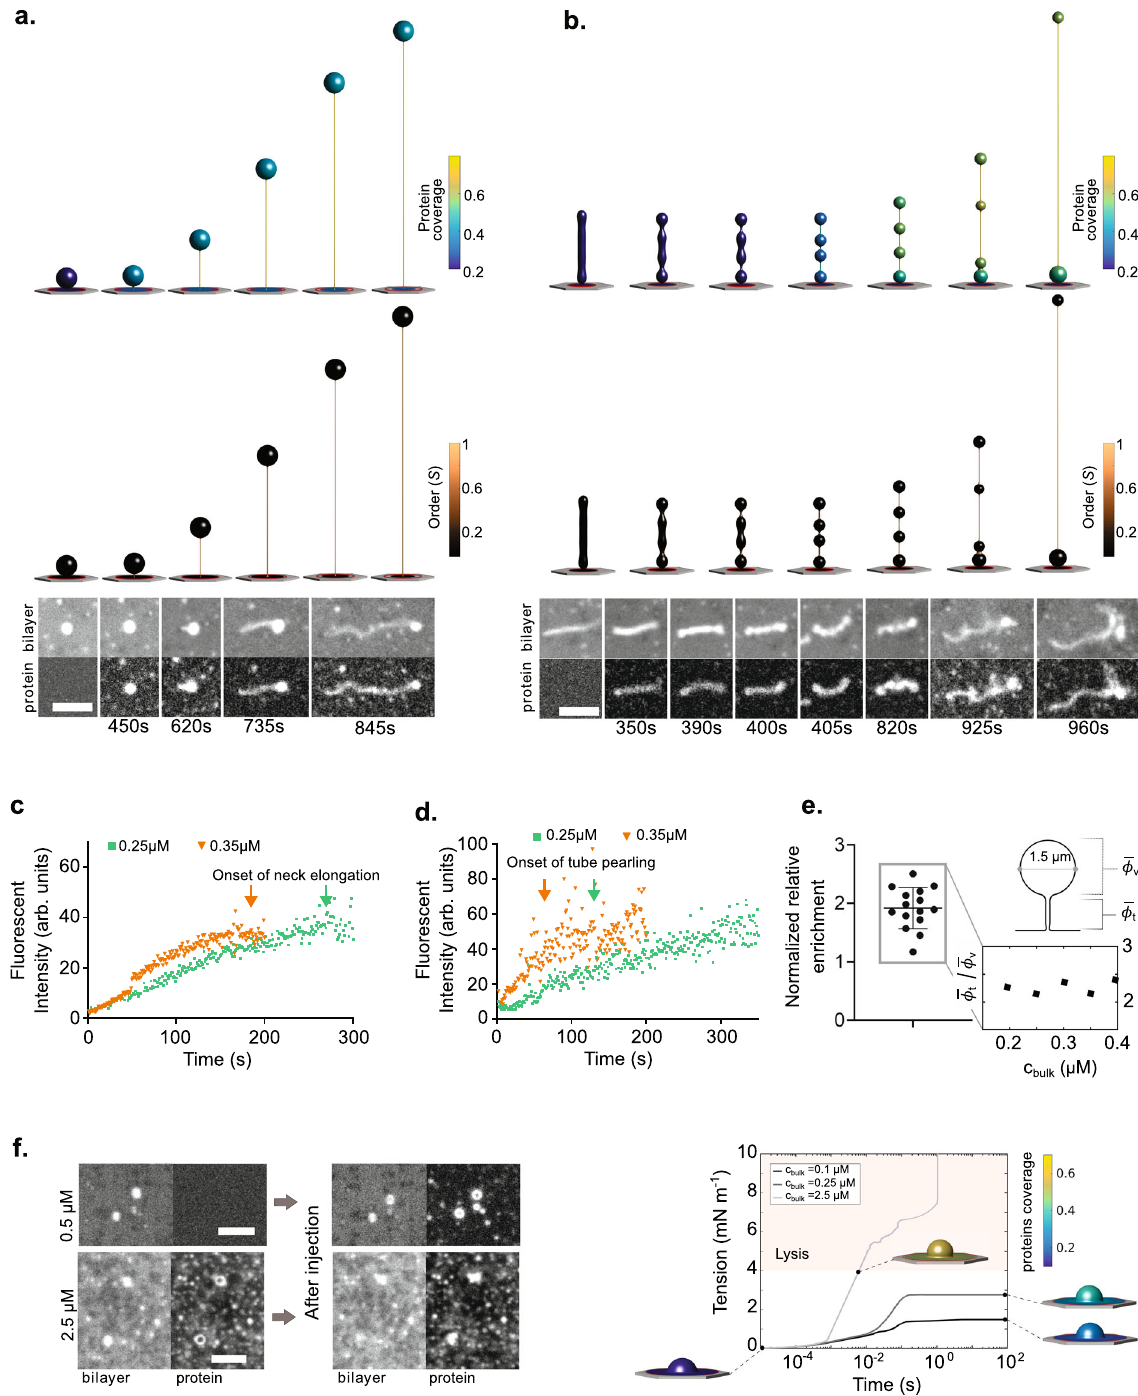
Fig. 3 Dynamics of membrane reshaping. a Results of simulations (top) and experiments (bottom) showing bud reshaping with time in response to Amphiphysin. Scale bar, 5 μ m. b Results of simulations (up) and experiments (down) showing tube reshaping with time in response to Amphiphysin. These simulations were performed using the reference mechanical ensemble described in Supplementary Note 1. Scale bar, 5 μ m. c Examples of Amphiphysin fl uorescence intensities in buds incubated at two different concentrations. Bud elongation times are marked with an arrow. Source data are provided as a Source data fi le. d Examples of Amphiphysin fl uorescence intensities in tubes incubated at two different concentrations. Tube pearling times are marked with an arrow. Source data are provided as a Source data fi le. e Ratios of protein coverage on tubes versus buds, normalized to the values measured for the lipid bilayer. Left: experimental values ( n = 15), right: theoretical concentration ratios ϕ t ϕ for a 1 µ m diameter bud, exposed to different bulk concentrations. v Data are shown as mean ± s.d. and source data are provided as a Source data fi le. f Left: Initial and fi nal states of pressurized caps (obtained from an hypoosmotic shock) upon incubation with Amphiphysin. At 2.5 µ M concentration, lysis of the caps can be observed. Scale bars, 5 μ m. Right: Model prediction in pressurized caps of about 1.5 µ m in diameter in radius exposed to different Amphiphysin concentrations. States in the pink shaded area are prone to membrane